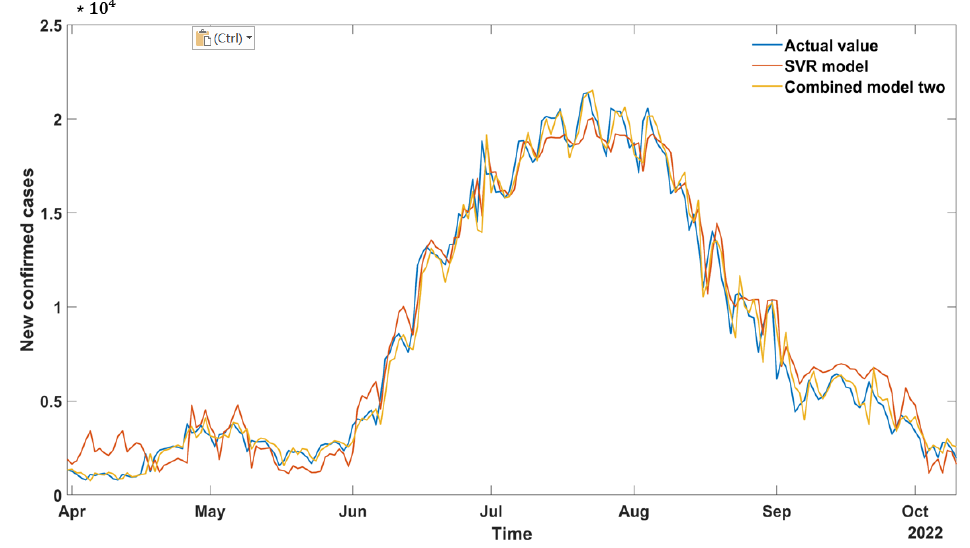
Figure 8. Comparison of the SVR model and the true value of India.